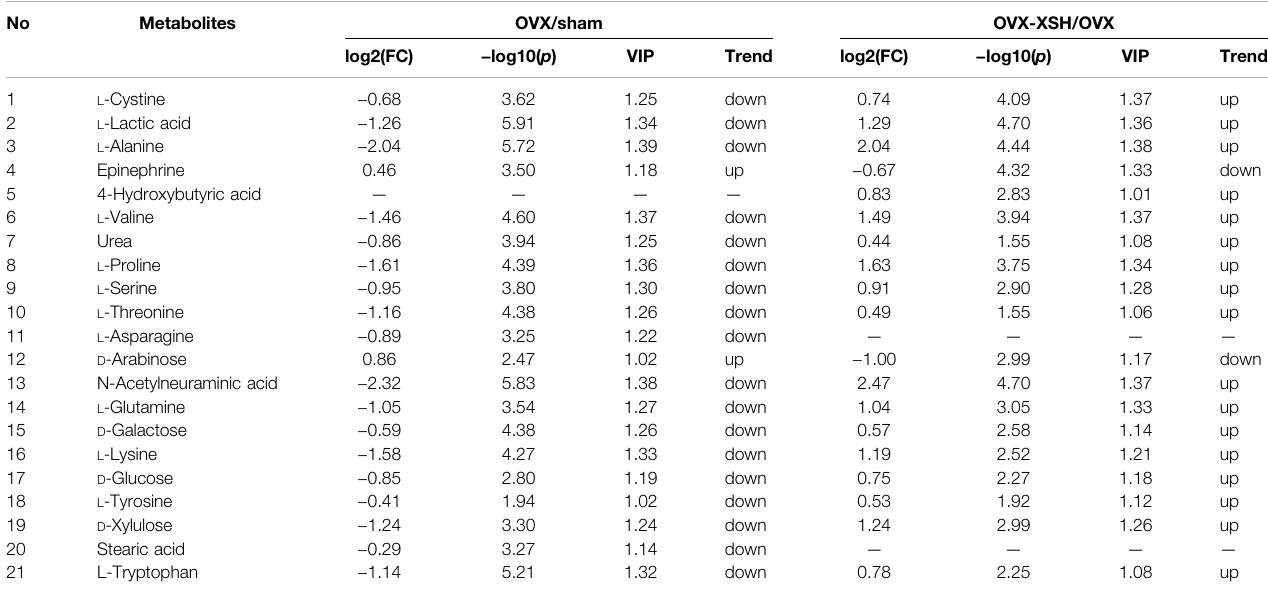
TABLE 3 | Signi fi cantly changed metabolites between different